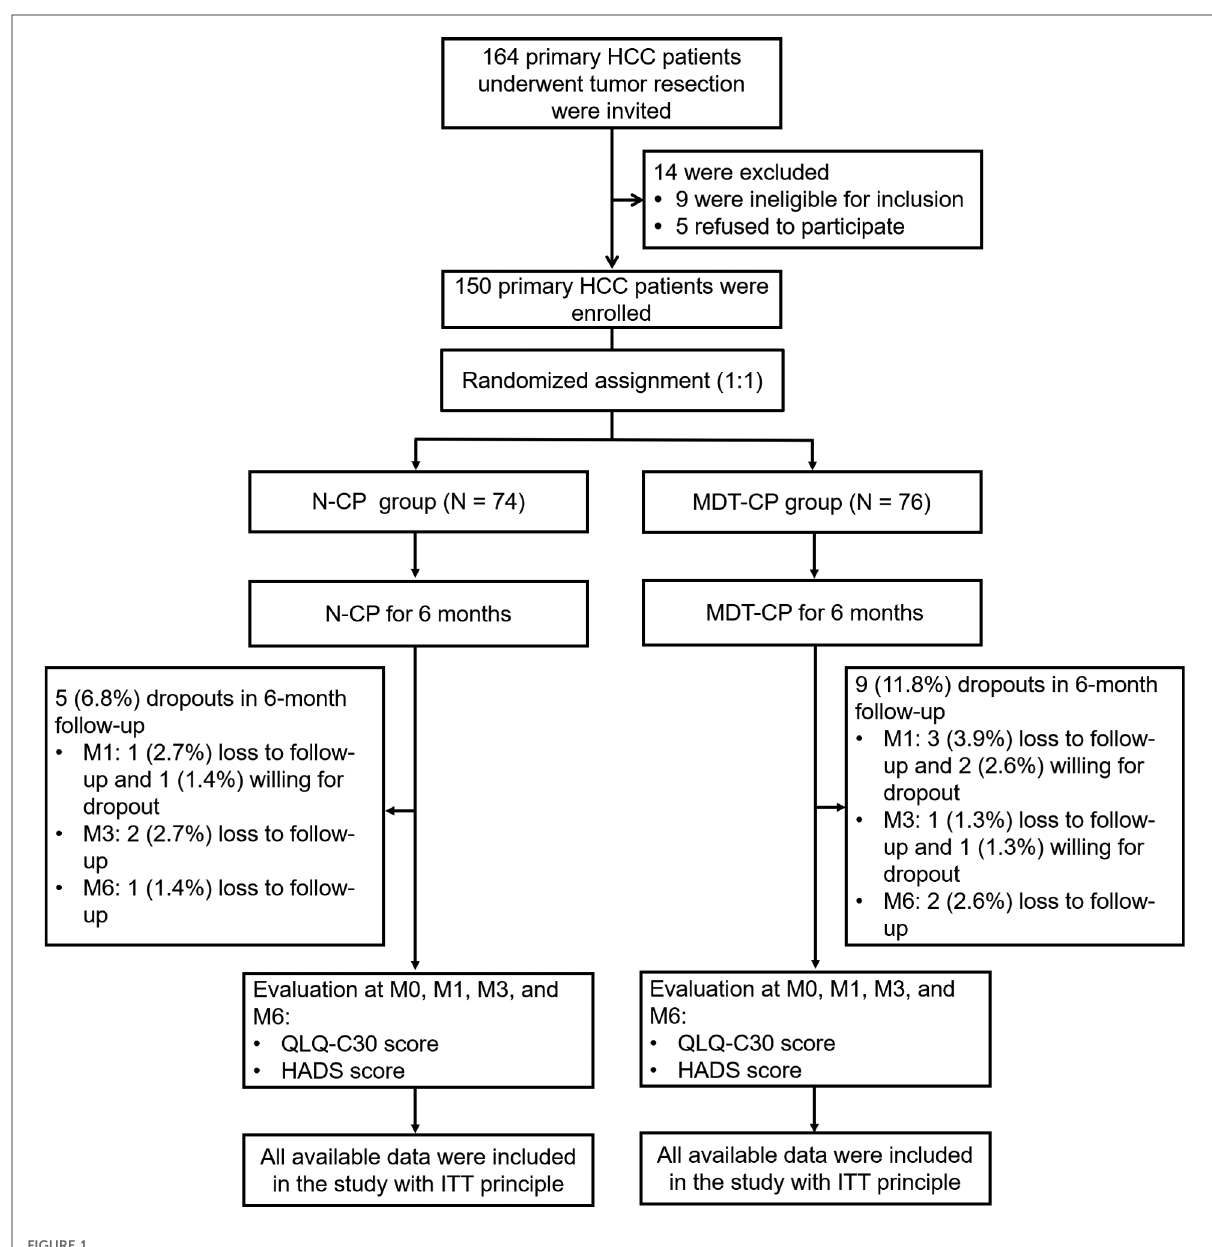
FIGURE 1 Study fl ow